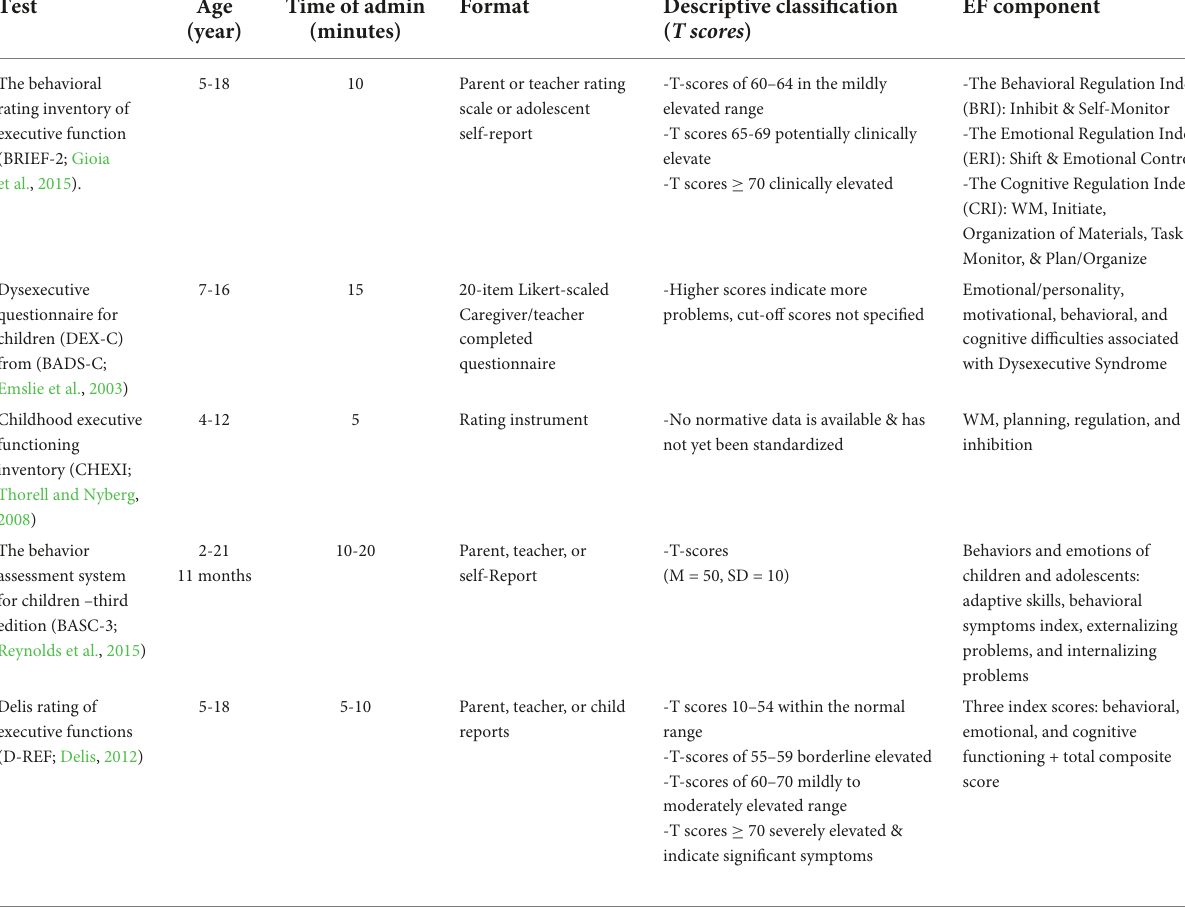
TABLE 2 Rating scales and inventories assessing executive functions ( EF) in school-aged children.